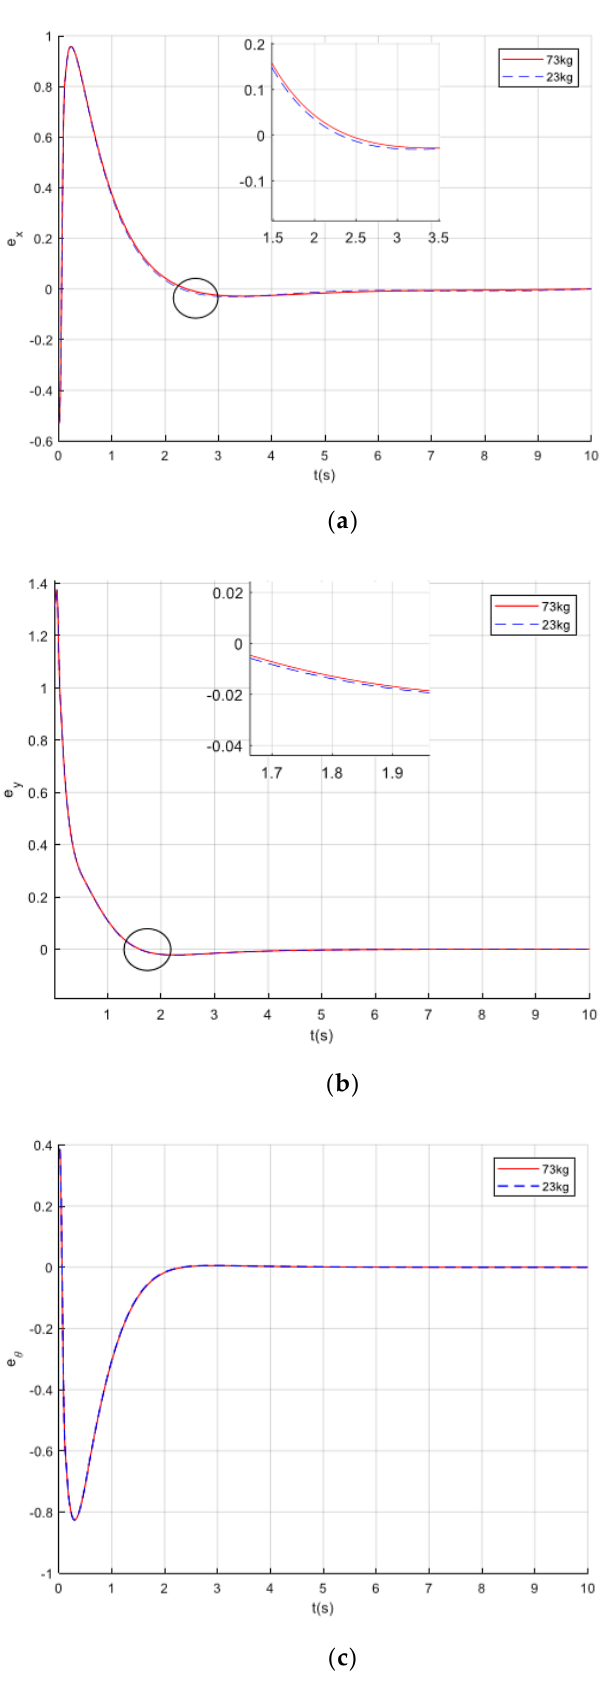
( c ) in tracking linear θ